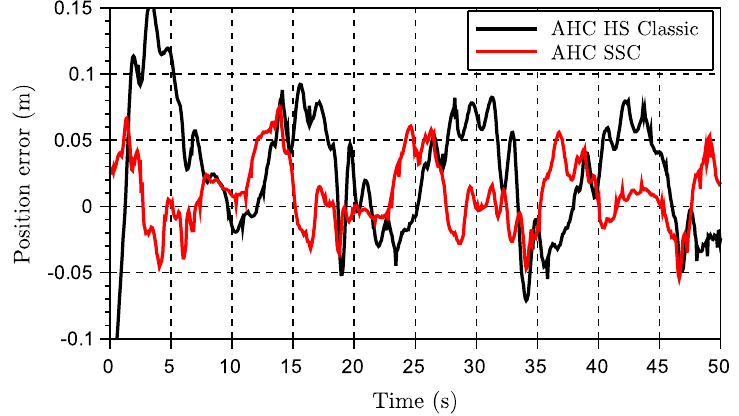
Figure 26. Control error for scenario